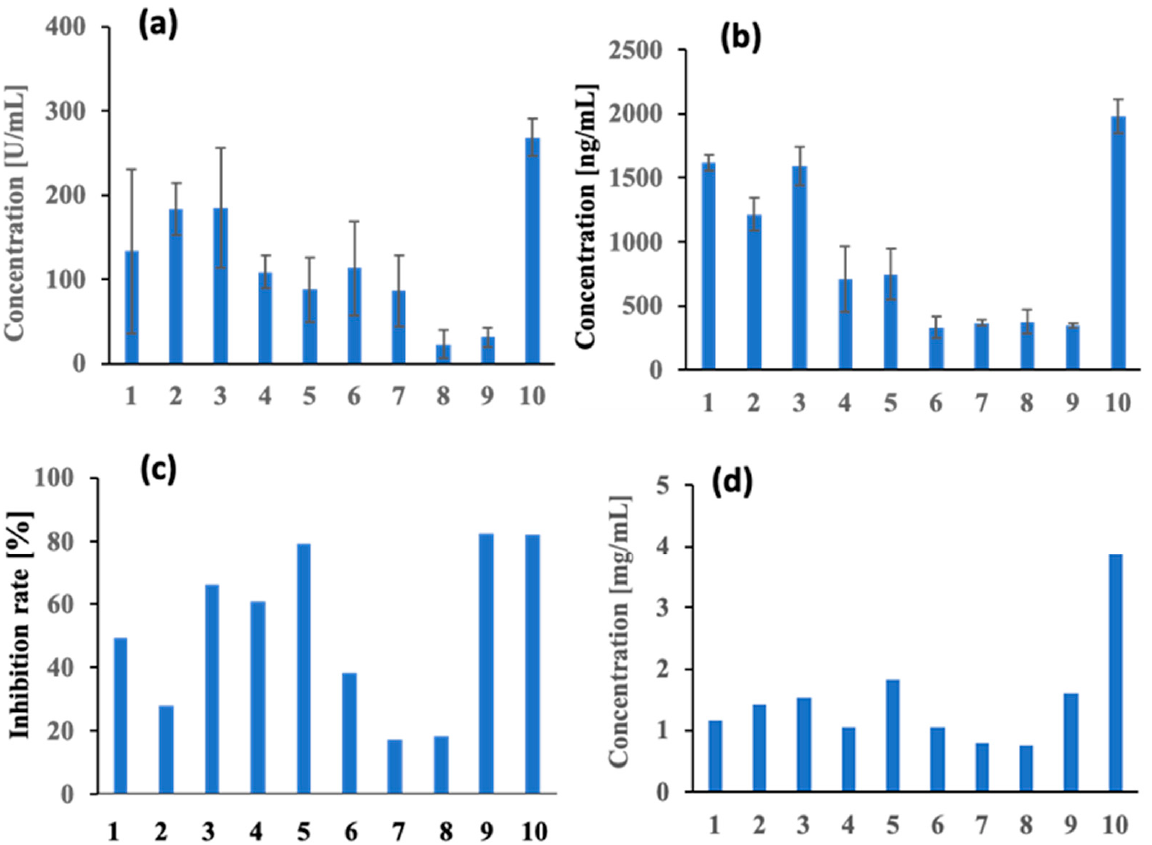
Figure 3. Comparisons of concentrations of neutralizing antibody IgG ( a ) and sIgA ( b ), antioxidant activity (indicated by luminescence inhibition rate) ( c ), and protein concentration ( d ) using saliva samples from 10 individuals are presented together. All 10 saliva samples were collected 3 weeks after the second dose of the vaccine.